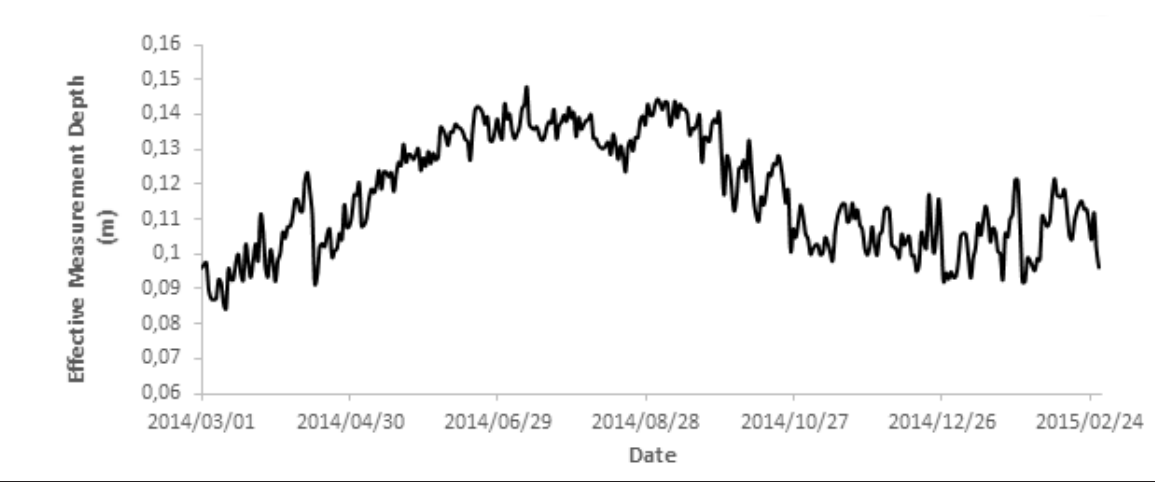
Figure 5: The cosmic ray probe’s effective measurement depth (m).